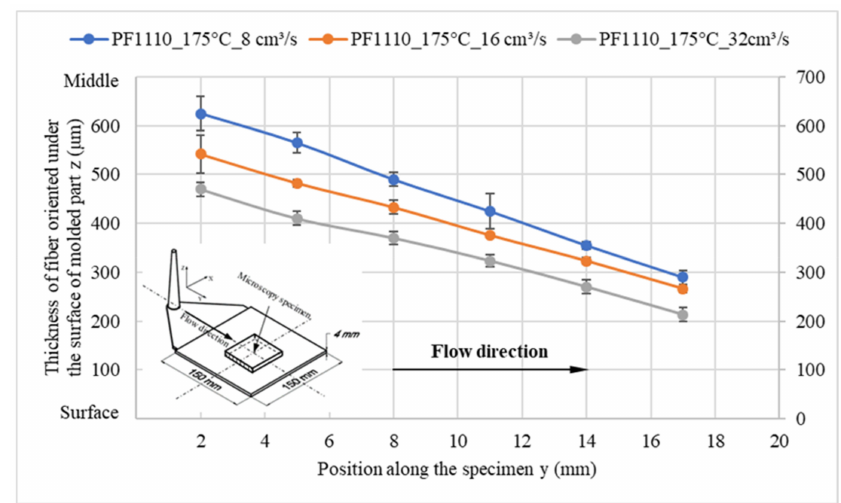
Figure 17. PF1110 (GF35+GB45); the influence of injection speeds on the fiber orientation under the surface of molded